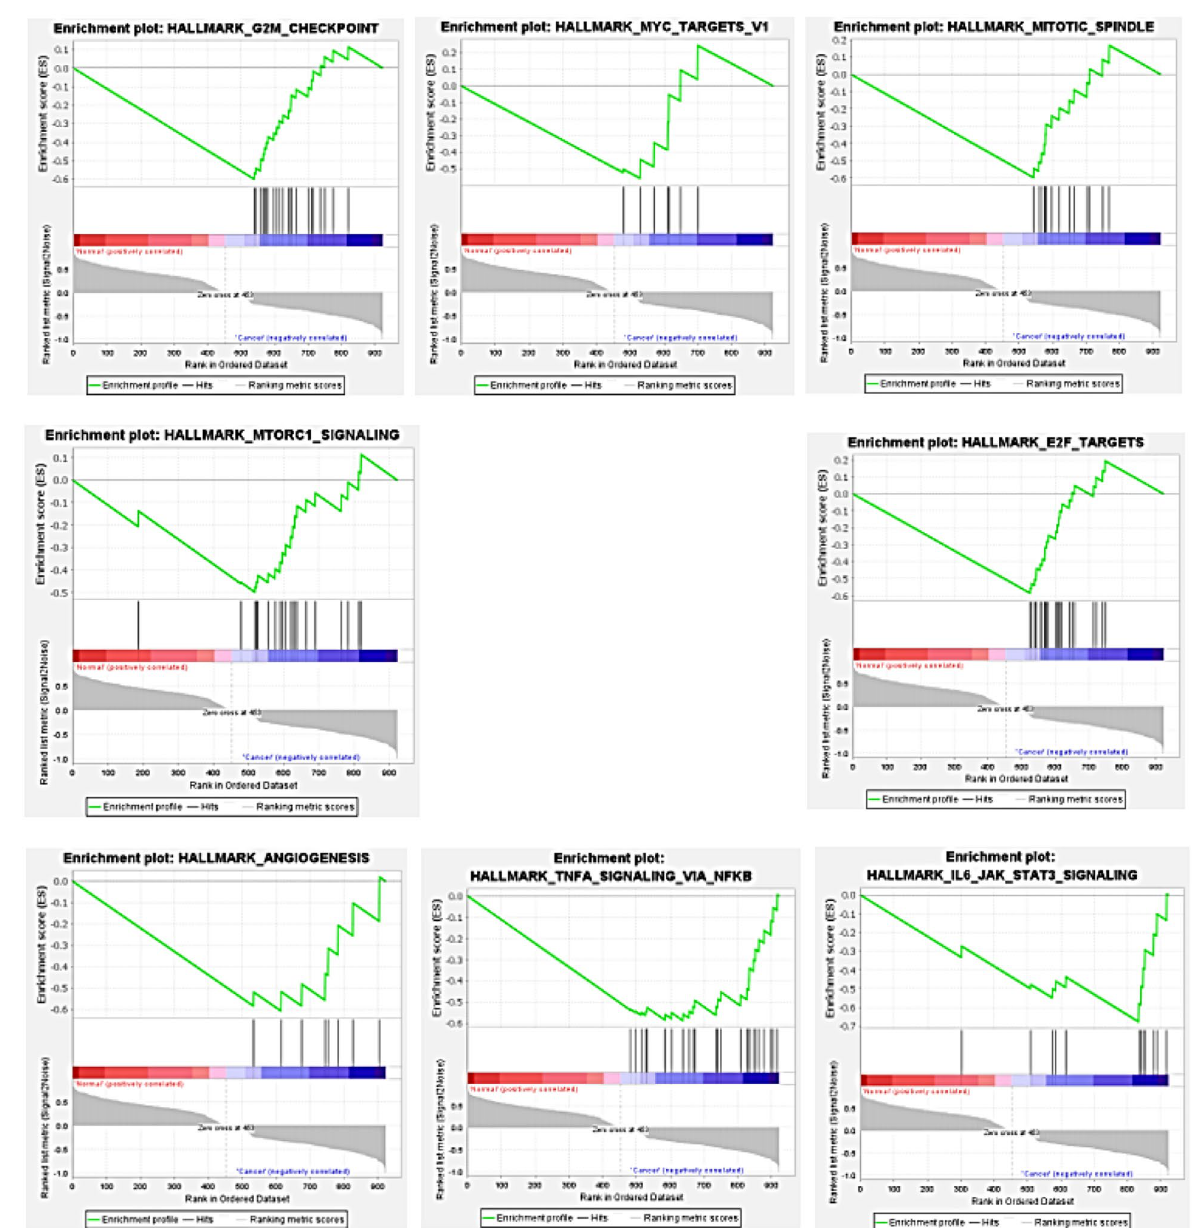
Figure 6. Results of GSEA analysis for DEGs with differential expression in CRC compared to